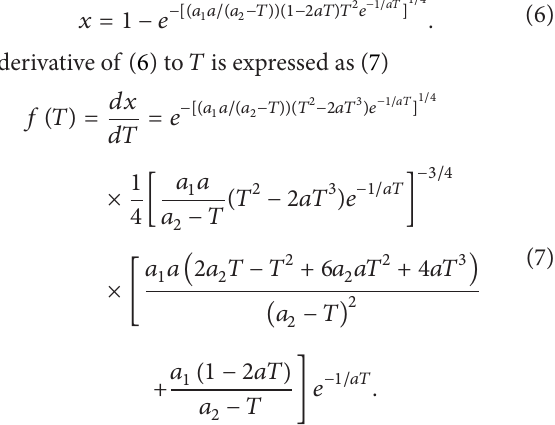
implies the preexponential factor; 𝐸 is the apparent activation energy, 𝑅 represents the gas constant 8.314; 𝑇 is the heating temperature; and 𝛽 is the heating rate. So (6) is got by finishing.